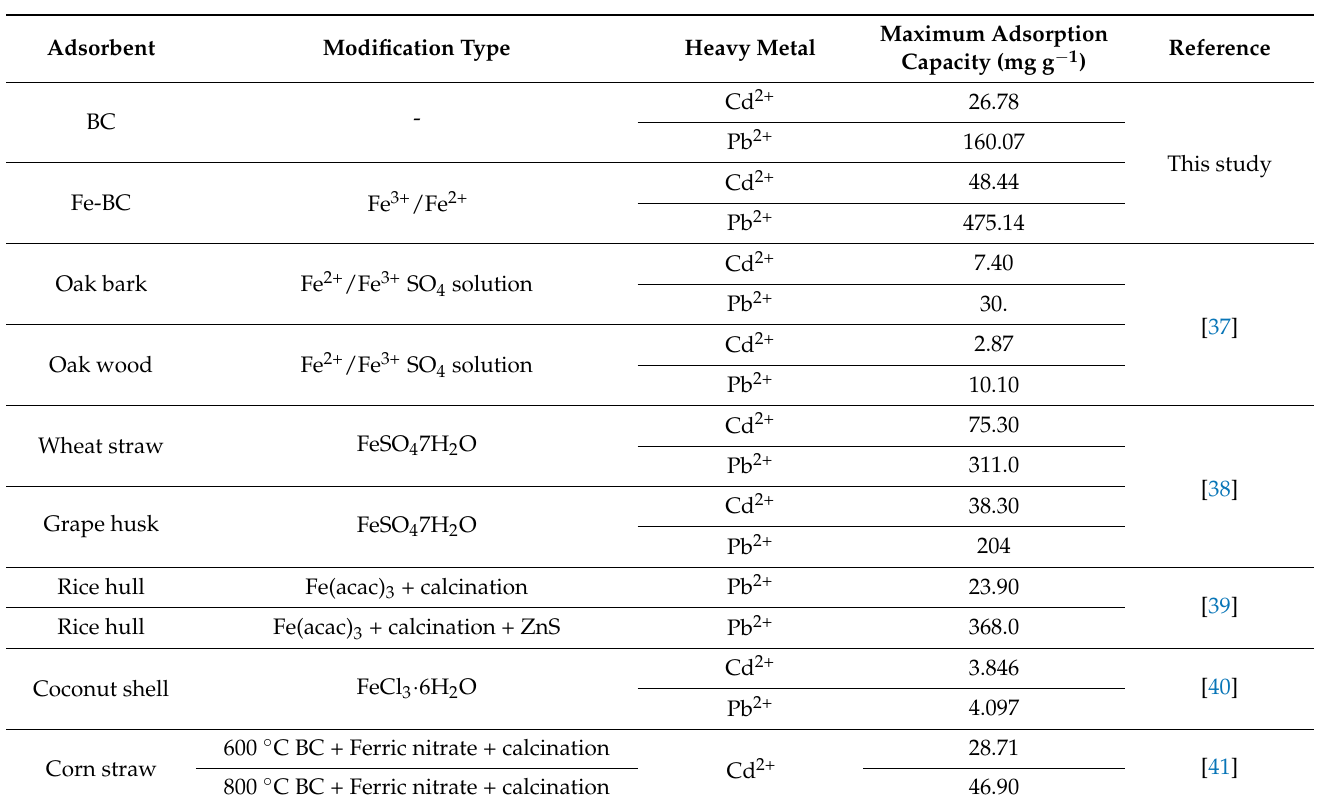
Table 5. Maximum adsorption capacities of different magnetic biochars for cadmium and lead from aqueous